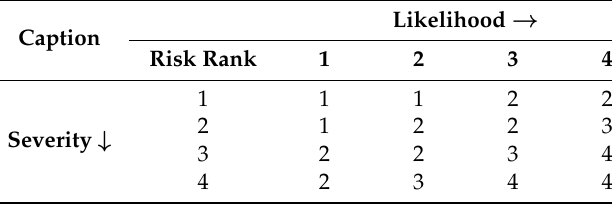
Table 4. Risk assessment matrix.